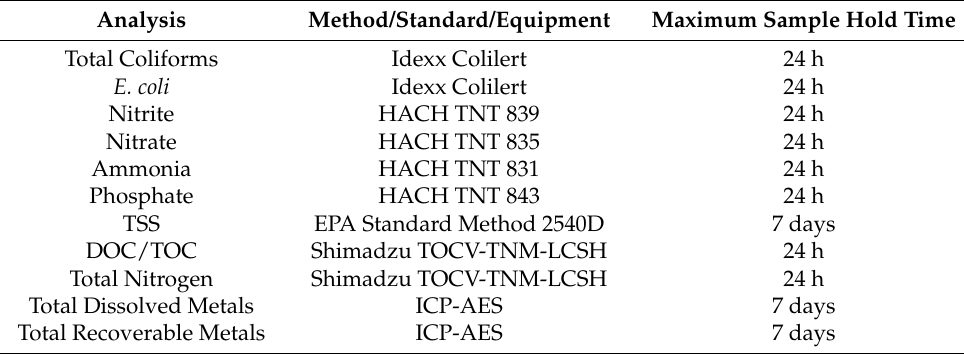
Table 2. Laboratory analysis methods, standards, and/or equipment and hold